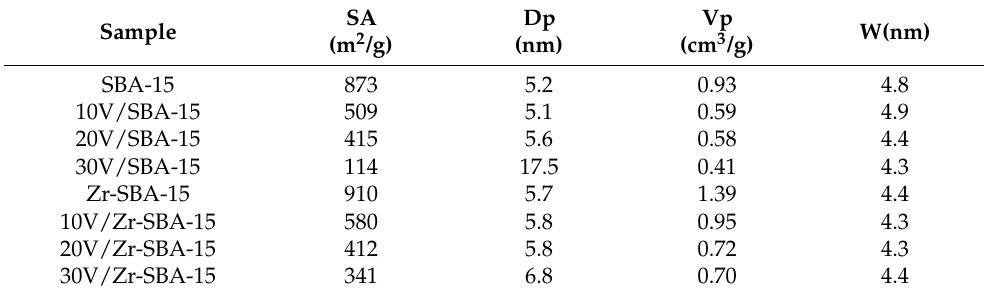
Table 1. Porosity and pore wall thickness of the SBA-15, Zr-SBA-15, V 2 O 5 /SBA-15, and V 2 O 5 /Zr- SBA-15